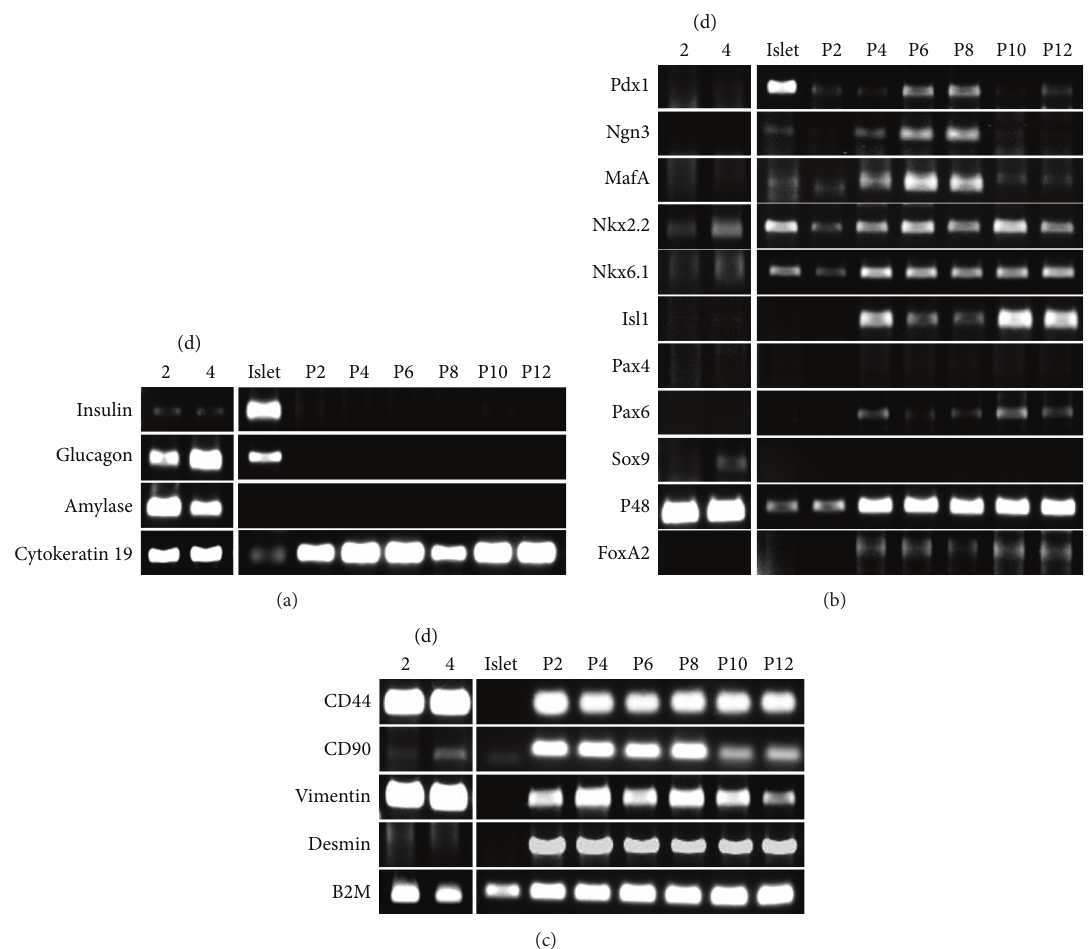
Figure 3: Pancreatic progenitor markers expressed in hpMSCs. RT-PCR analysis of mRNA expression in exocrine cells, hpMSCs, and control human islets. Exocrine mRNA was extracted at culture days 2 and 4, and hpMSC mRNA was isolated from cells on passage days 2, 4, 6, 8, 10, and 12. (a) Cytokeratin 19 was expressed in all passages of hpMSCs, whereas insulin, glucagon, and amylase were not. (b) Pancreatic cell transcription factors, including those required for development and differentiation, exhibited different expression levels depending on passage. Key transcription factors Pdx1, Ngn3, and MafA were detected from passages four through eight in culture cells; Nkx2.2, Nkx6.1, and P48 were expressed in all hpMSCs without being affected by cell passage, and Isl1 and Pax6 expression was initiated during passage four. Weak expression of Nkx2.2 and Nkx6.1 and strong expression of the P48 exocrine-cell marker were detected in exocrine cells. (c) hpMSCs continue to display markers associated with hpMSCs, including CD44, CD90, vimentin, and